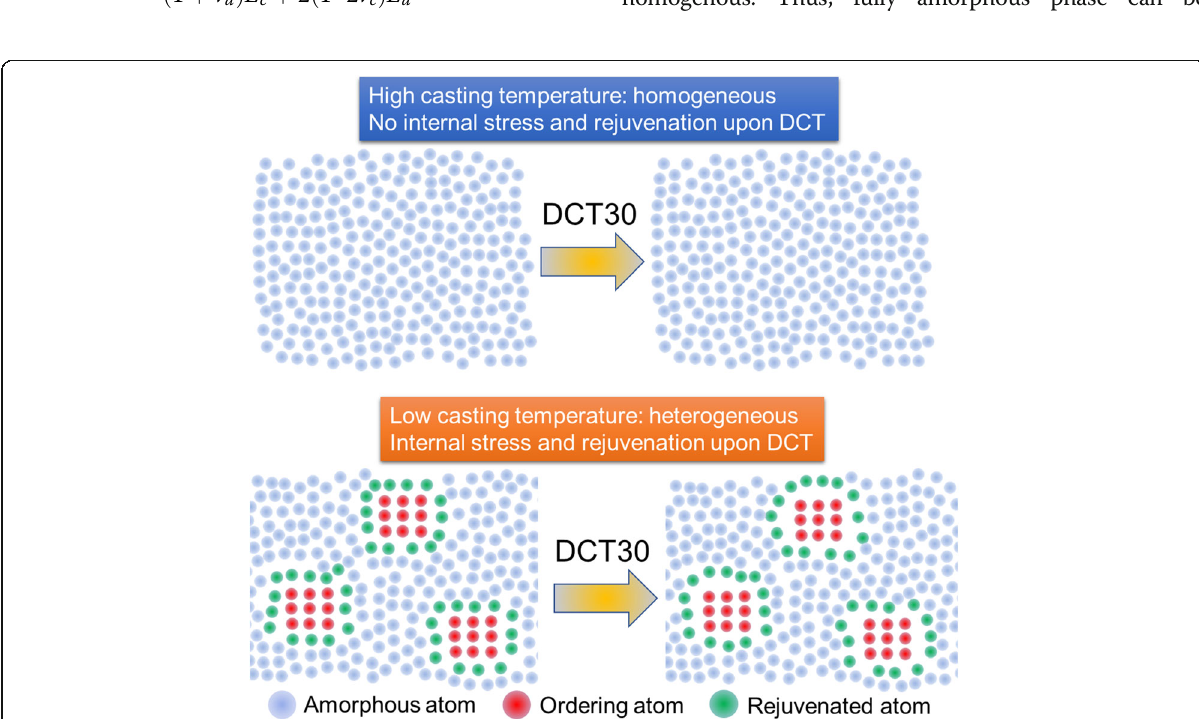
Fig. 5 Schematic illustration of rejuvenation behavior for both HT and LT samples. Homogeneous structure of HT sample cannot generate internal stress upon DCT, while heterogeneity in LT samples helps generate internal stress at the interfaces. Therefore, rejuvenation behavior can be only observed in LT